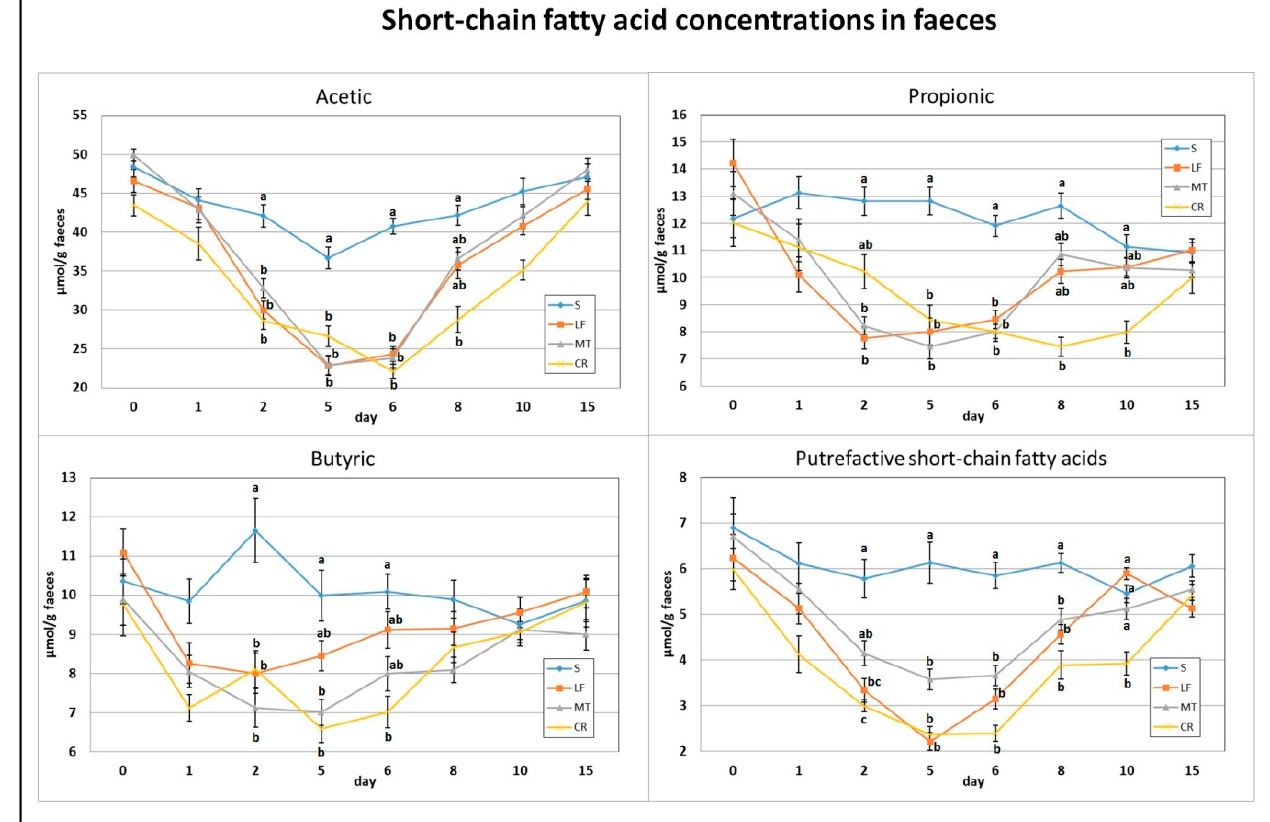
Figure 4. Experimental factor in particular groups: S — control standard diet (0–15 days); LF — standard diet with lactoferrin addition 100 mg/kg (0–5 days diet LF and 6–15 days diet S); MT — standard diet with melittin addition 100 mg/kg (0–5 days